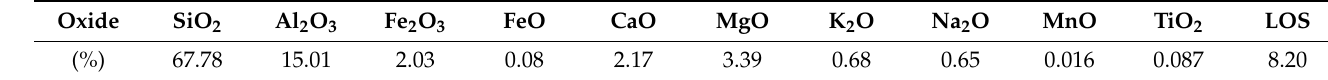
Table 3. Chemical properties of